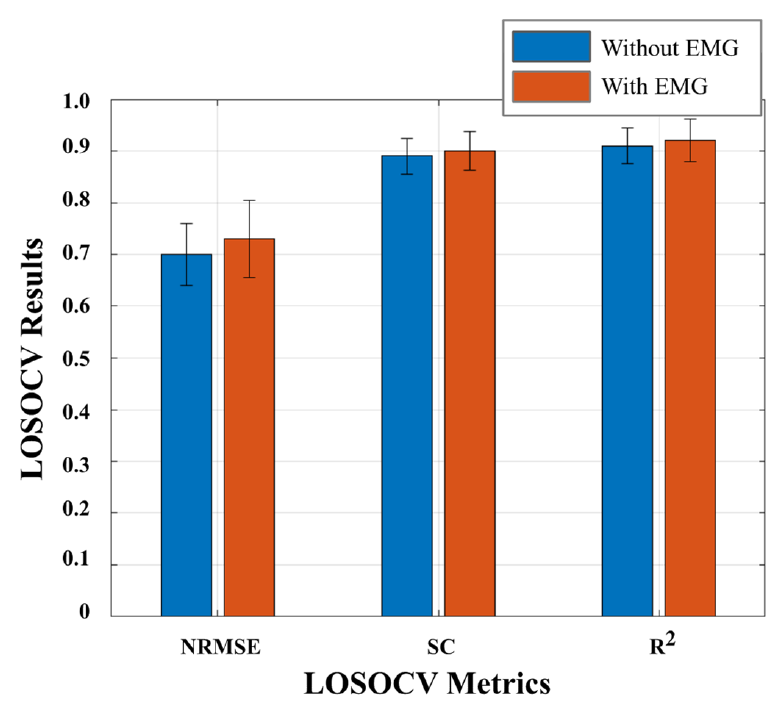
Figure 6. LOSOCV results for both DL regression models using EMG signals. Table 3. NRMSE, SC, R 2 , and computational time results for both DL models without using EMG signals. DL Model